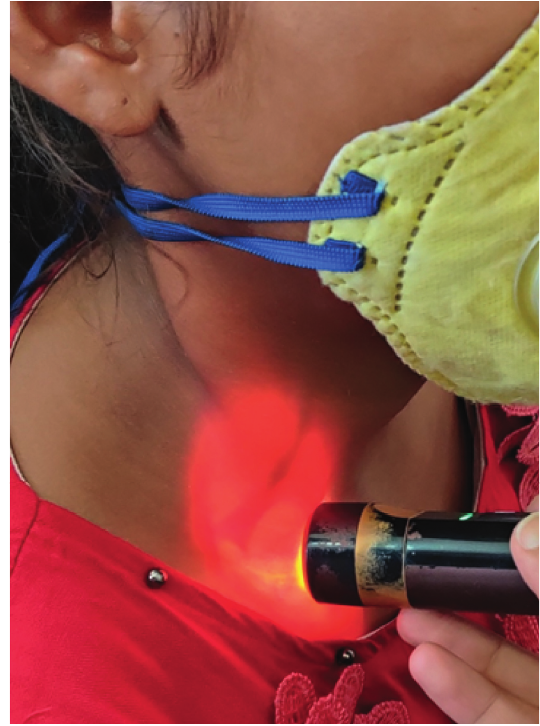
Figure 2: Positive transillumination test of the patient with the shadow of shunt in